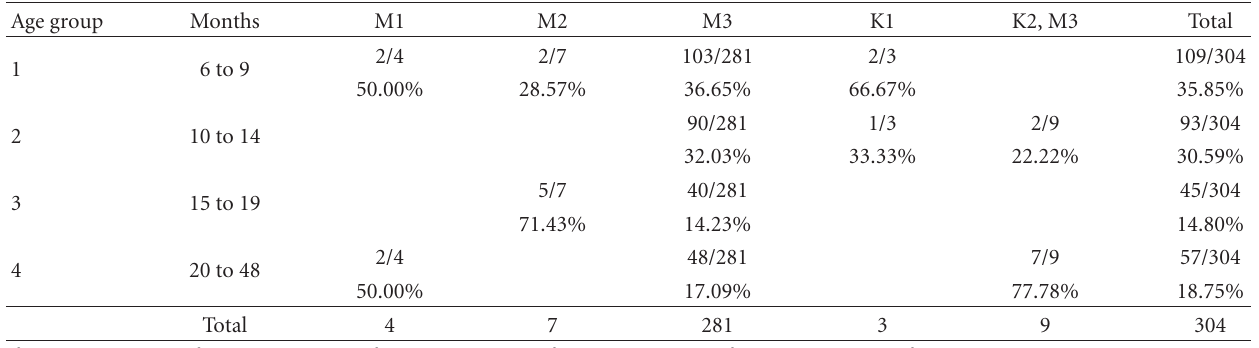
Table 2: Di ff erent kinds of malnutrition with the 304 children according to the age groups.